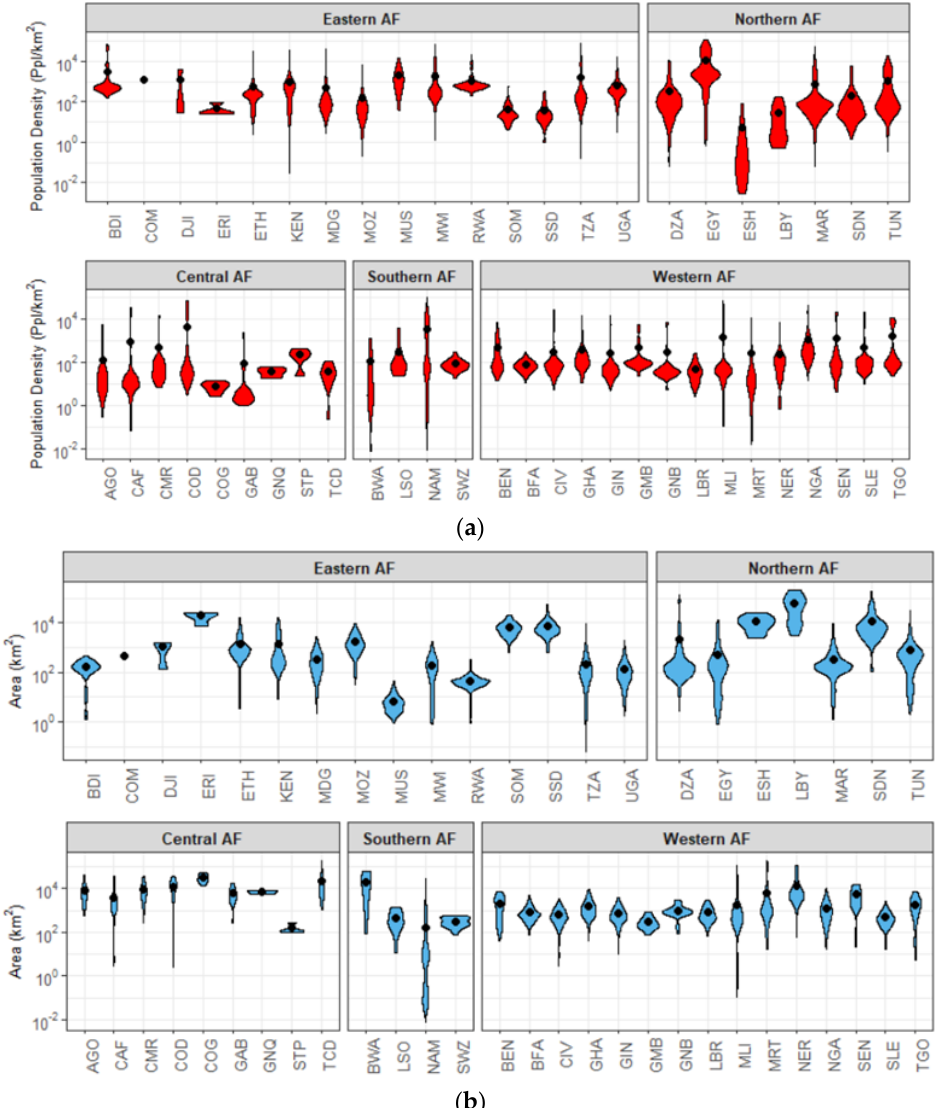
Figure 4. ( a ): Violin plots illustrating the distribution of the population density (ppl/km 2 ) of the sample L1-units within each country. Black dot: mean value of the distribution, not to be confused with the average population density of the country. ( b ): Violin plots illustrating the distribution of the sampled L1-units within each country in terms of their actual size (km 2 ). Black dot: mean value of distribution.